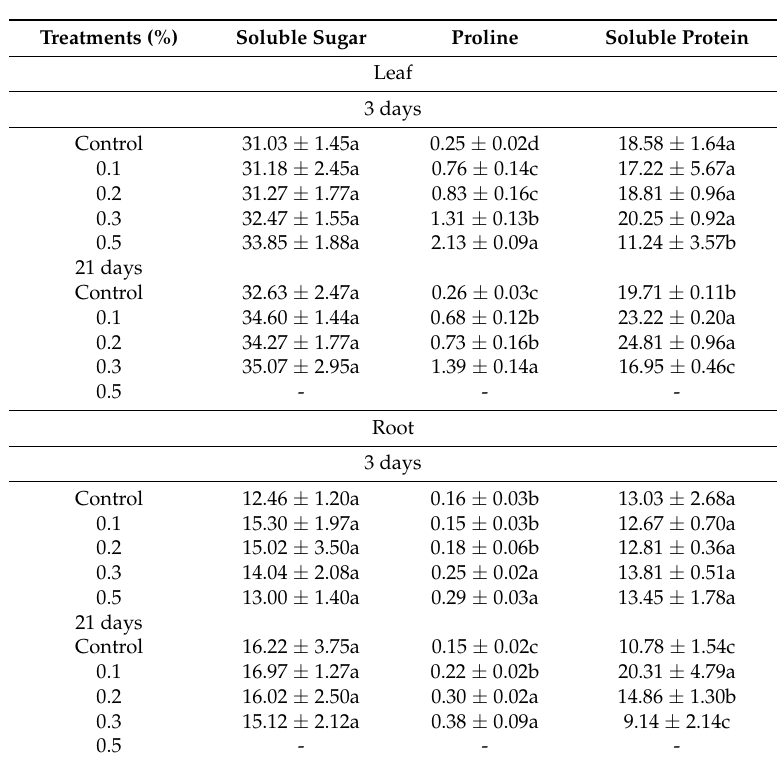
Table 4. Effect of soil salinity on the concentrations of soluble sugars (mg g − 1 FW), proline (mg g − 1 FW), and soluble proteins (mg g − 1 FW) in the lateral roots and leaves of mulberry plants grown for 3 and 21 days under greenhouse conditions. Data in each column with the same letter are not significantly different ( P = 0.05).